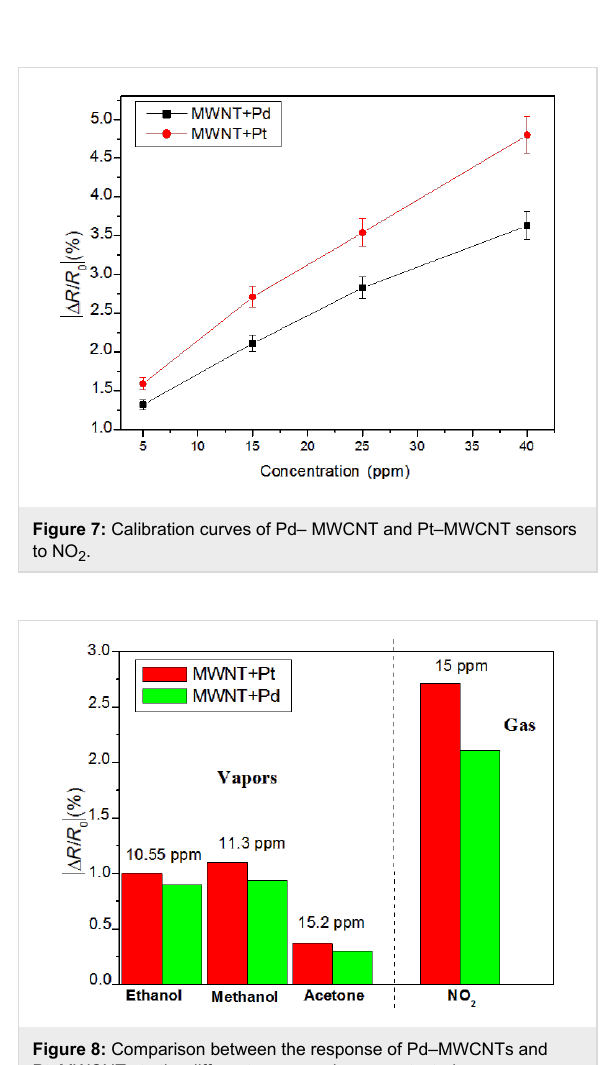
The mean sensitivity (mean slope of the calibration curve calcu- lated over the whole concentration range) for the Pd- and Pt-